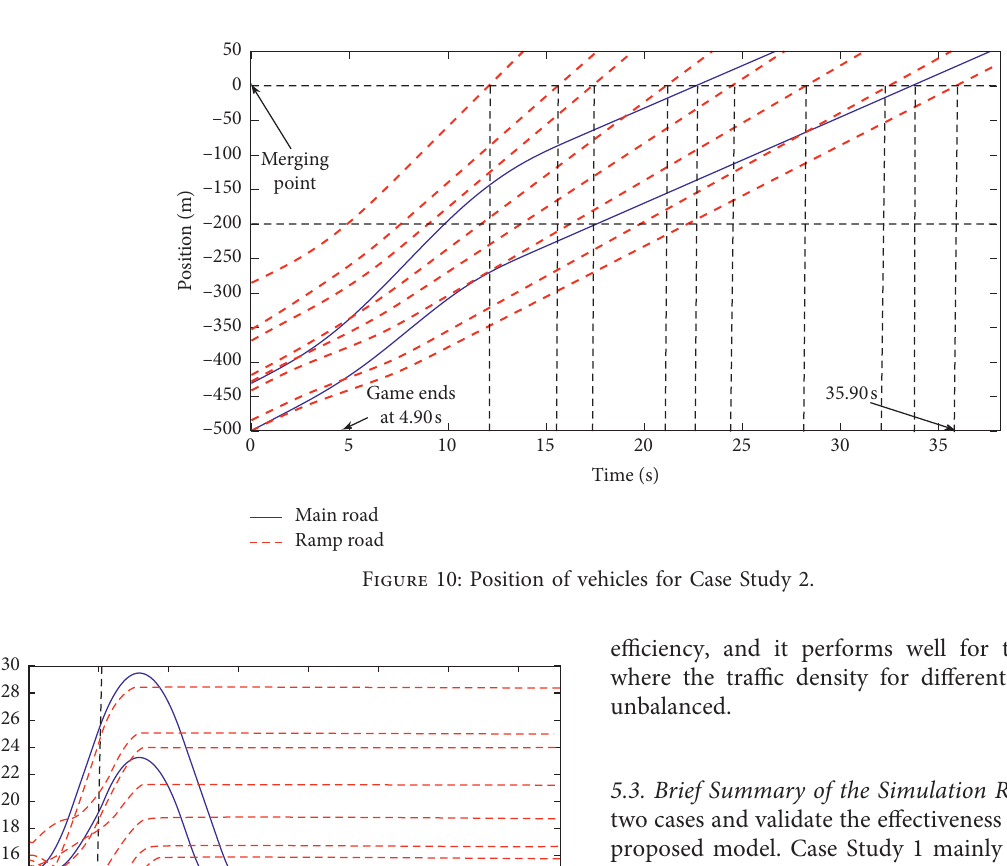
Figure 9: Comparison of fuel consumption for different models in Case Study